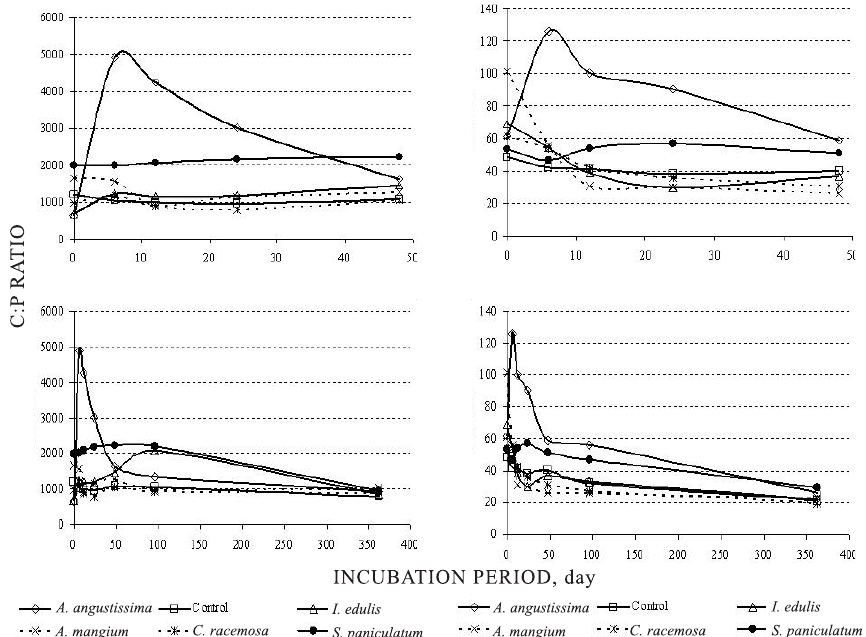
Figure 4. Carbon-to-P ratio and N-to-P ration for different legume treatment and control (as natural fallow vegetation), for 48 and 362 days of incubation